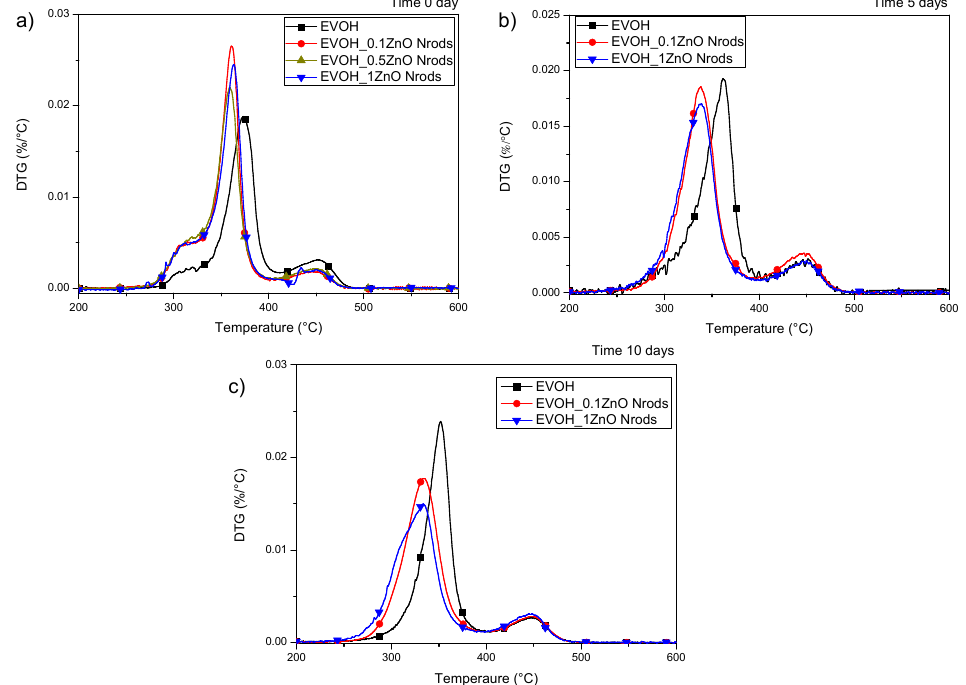
Figure 5. Derivative curves (DTG) of EVOH-based formulations before, and after different exposition times during the accelerated-aging test. ( a ) time = 0 ( b ) 5 days; ( c ) 10 days.